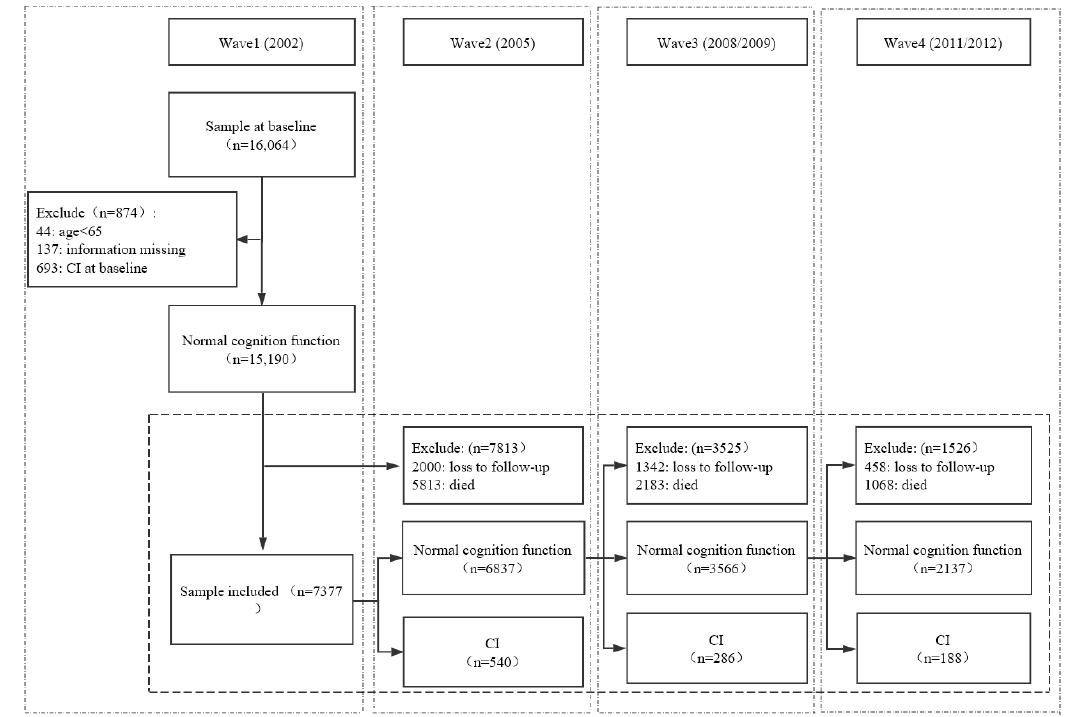
Figure 1. Flow chart of sample selection, CLHLS 2002–2012. * CI = cognitive impairment.